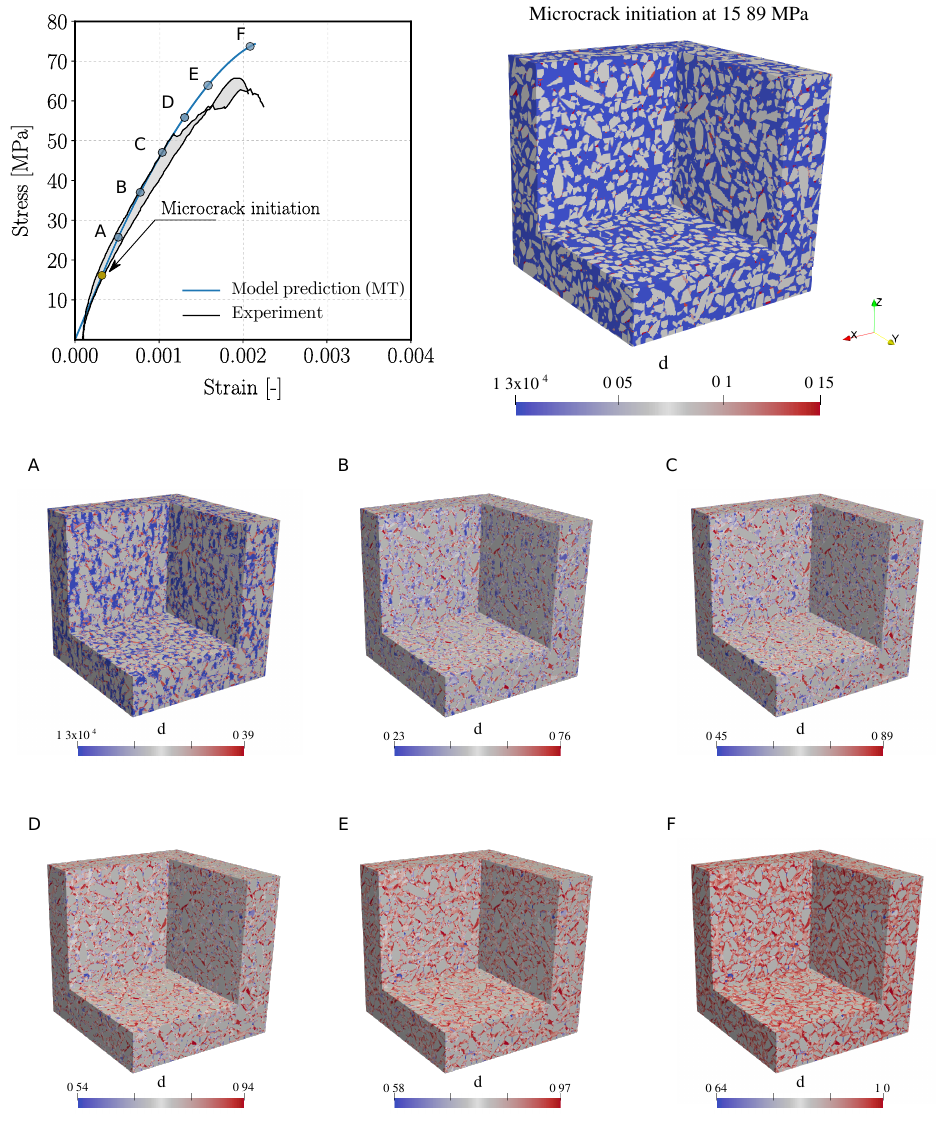
Figure 14. Top left: Stress–strain curves obtained from the simulation (blue line) and the experi- ment (black lines), Top right: Visualisation of damage distribution at a microcrack initiation state. From ( A – F ): Opening of vertically oriented microcracks in the mortar matrix at six different load levels (25.77, 37.05, 47.06, 55.88, 63.41, 73.71 MPa, red color indicates active microcracking